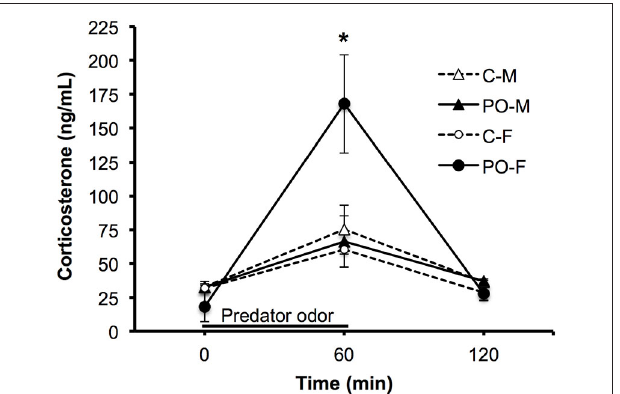
FIGURE 4 | Adult offspring from dams exposed to predator odor during pregnancy (PO) show an altered predator odor-challenged levels of CORT to a predator odor compared to control (C) adult offspring . M, male; F, female. The black line shows the duration of the predator odor exposure. Data are average ± SEM. * P ≤ 0.05, post hoc comparison within female